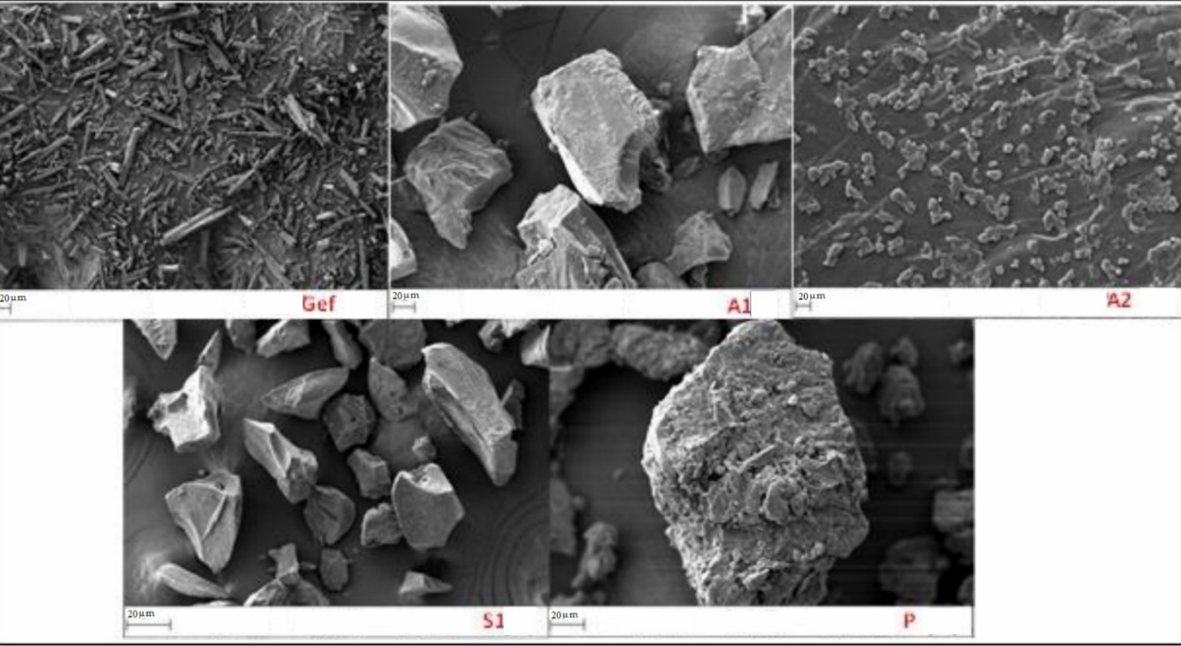
Figure 4. SEM images of pure Gef and various SDs (A1-MW, A2-MW, S2-MW, and P-MW) prepared using microwave